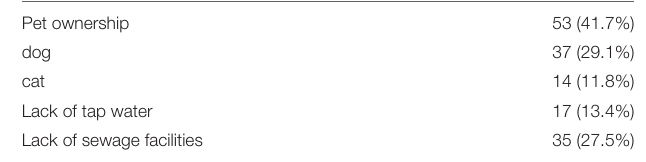
TABLE 1 | Demographic, clinical characteristics, and environmental exposures of the study children ( n =